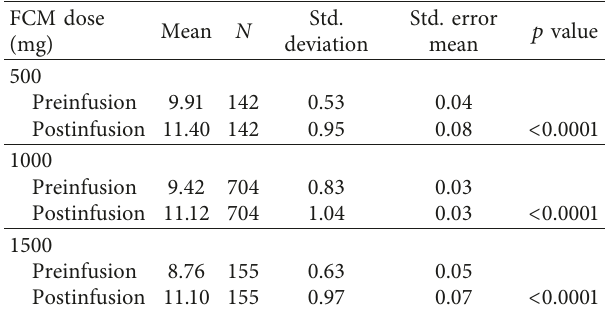
Table 2: Clinical laboratory parameters. Table 3: Mean change of hemoglobin from pre- to postinfusion by FCM doses.